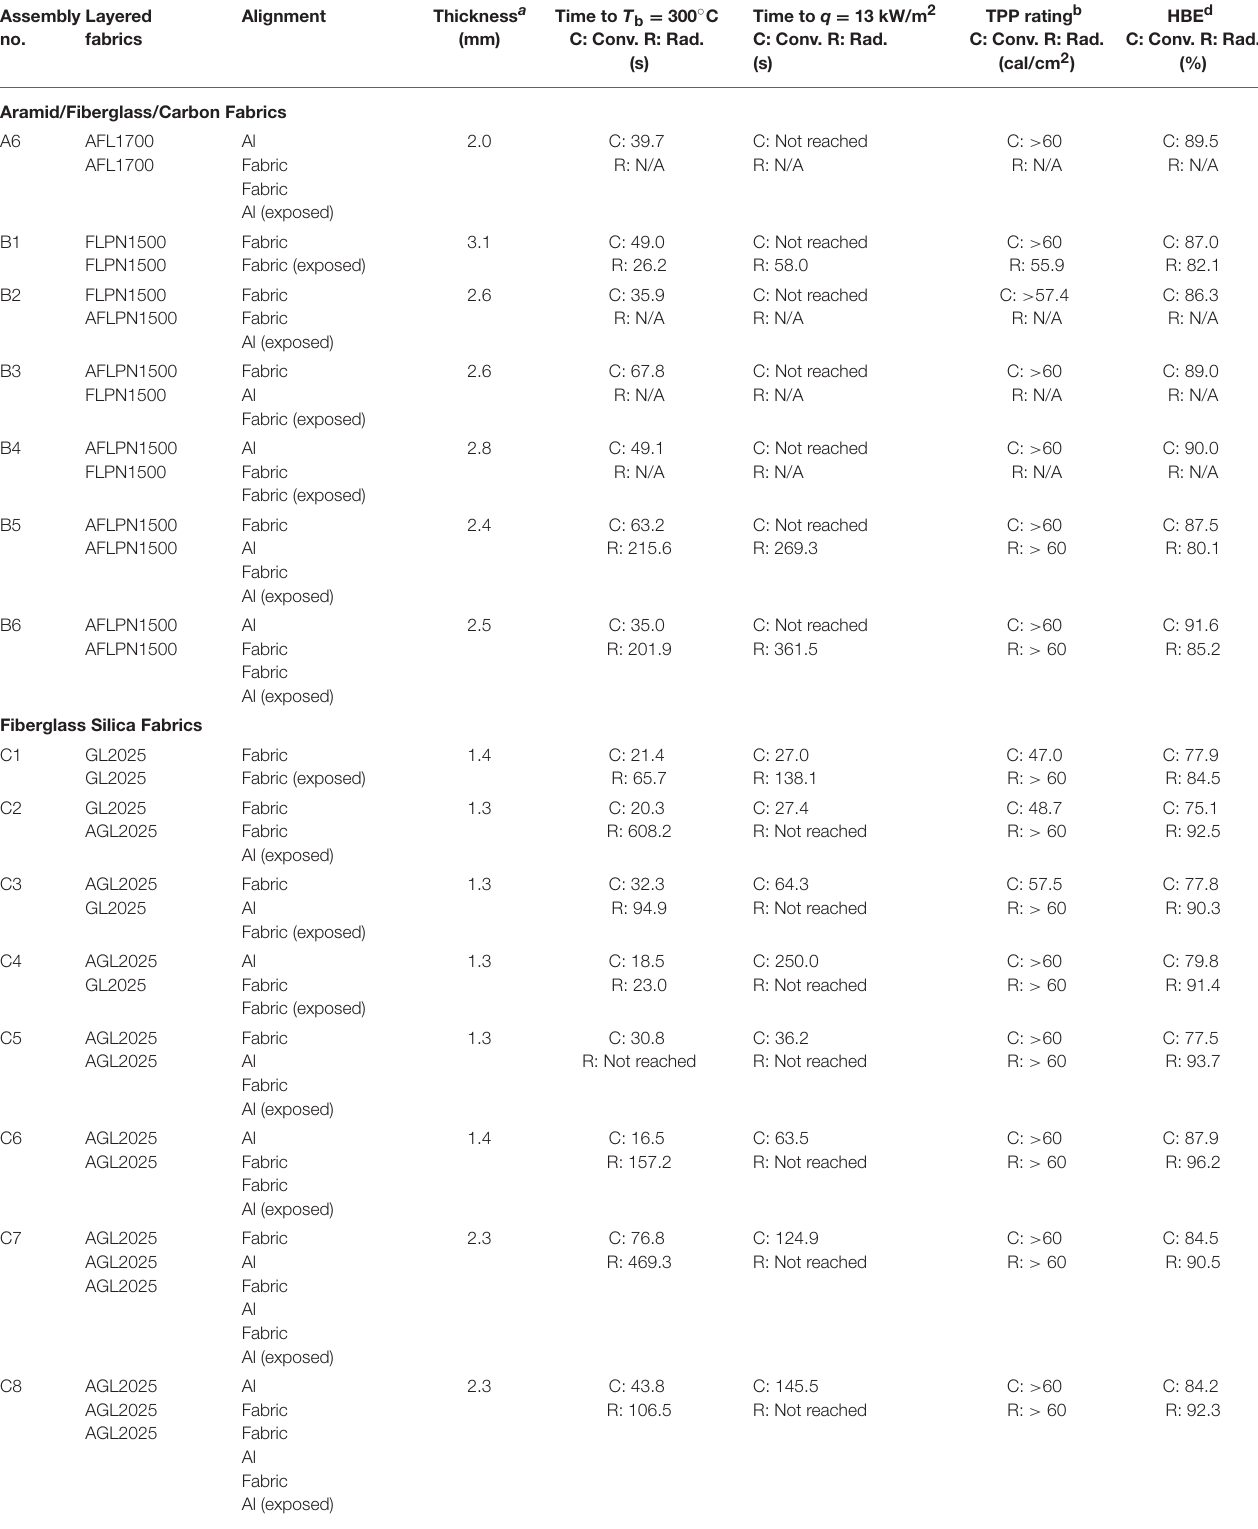
TABLE 3 | Measured thermal characteristics of multiple-layer fire blankets. Assembly